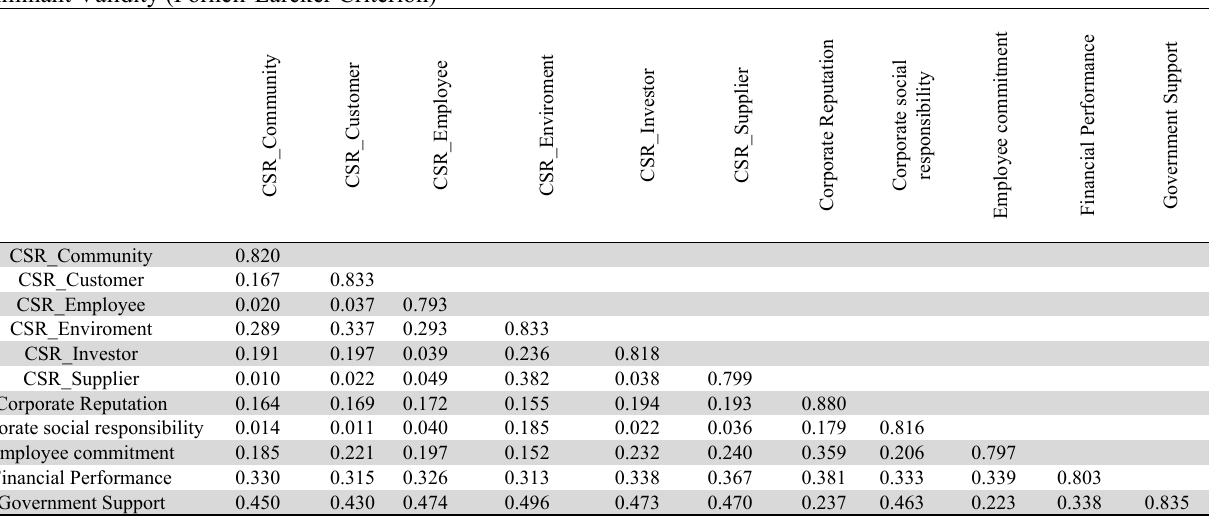
Discriminant Validity (Fornell-Larcker